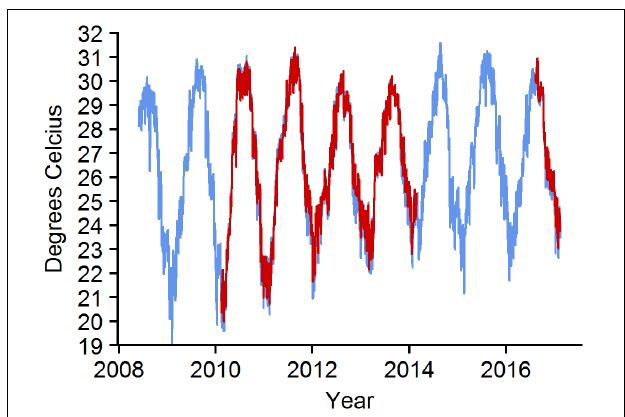
FIGURE 7 | Daily mean water temperature at BCA—blue and Scooter—red. Missing data for Scooter from 2014 to 2016 are due to faulty